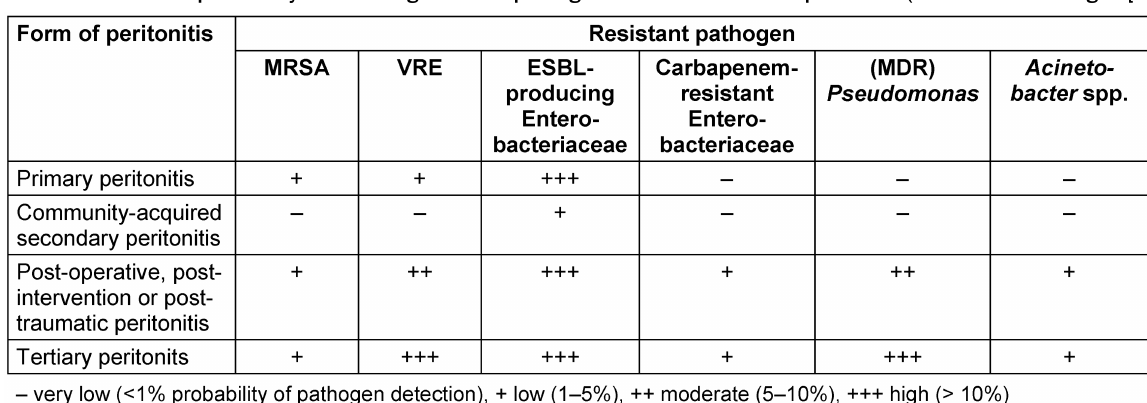
These are tigecycline [59], linezolid [60], and also to some extent daptomycin (no controlled clinical data). Cases